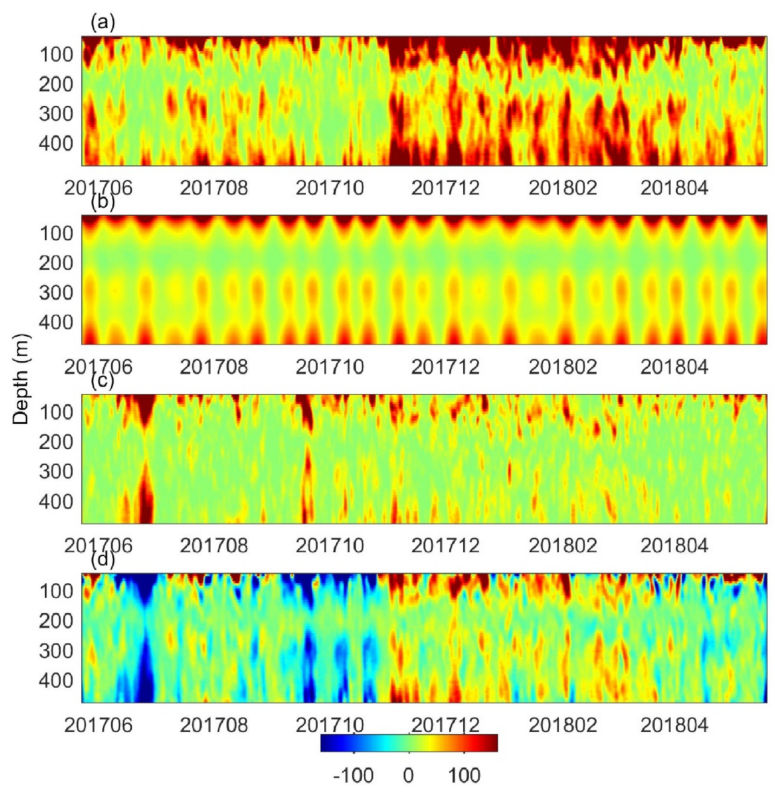
Figure 6. The HKEs (unit: J m − 1 ) of semidiurnal currents ( a ) and their coherent component ( b ), incoherent component ( c ) and cross-term ( d ).